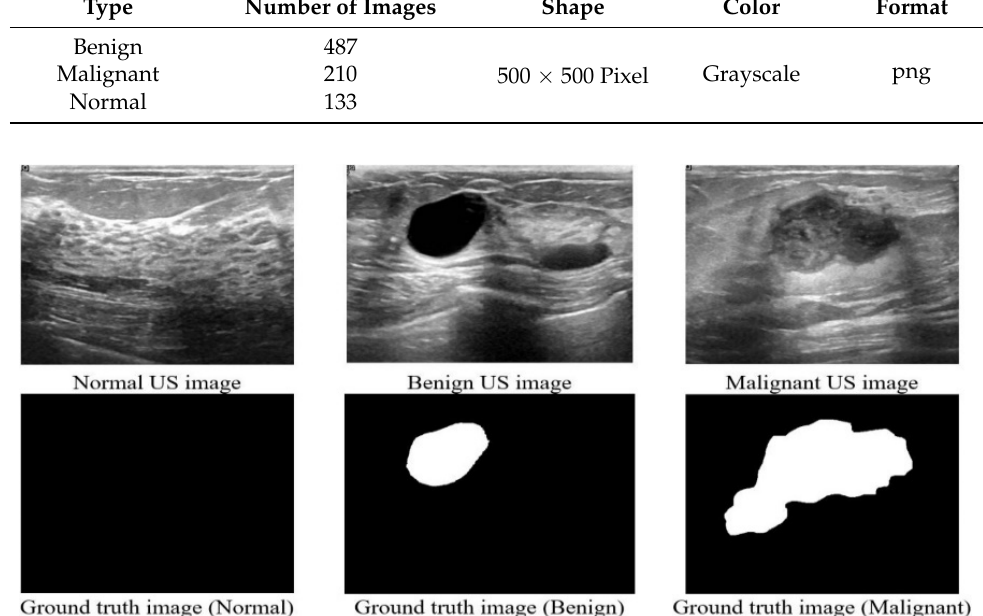
Figure 1. Sample images from the